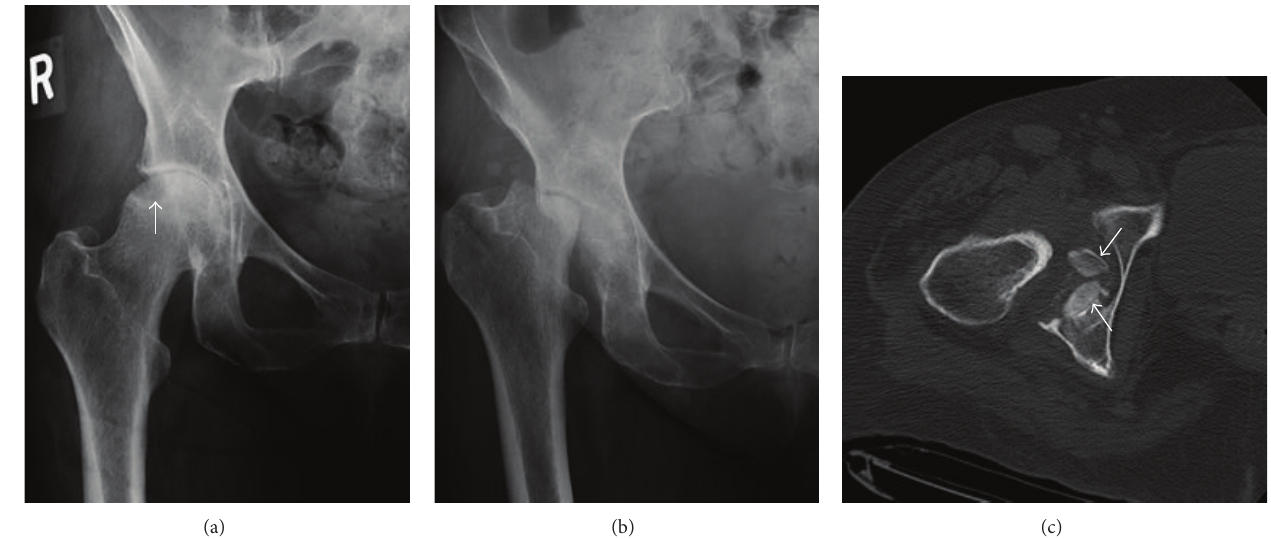
Figure 1: (a) AP radiograph of the right hip. A focal area of subchondral lucency is present involving the superolateral aspect of the right femoral head (arrow). (b) The follow-up radiograph taken 5 months later reveals near complete destruction of the femoral head. (c) CT scan of the right hip in the axial plane shows loss of the femoral head with two bone fragments within the hip joint (arrows).